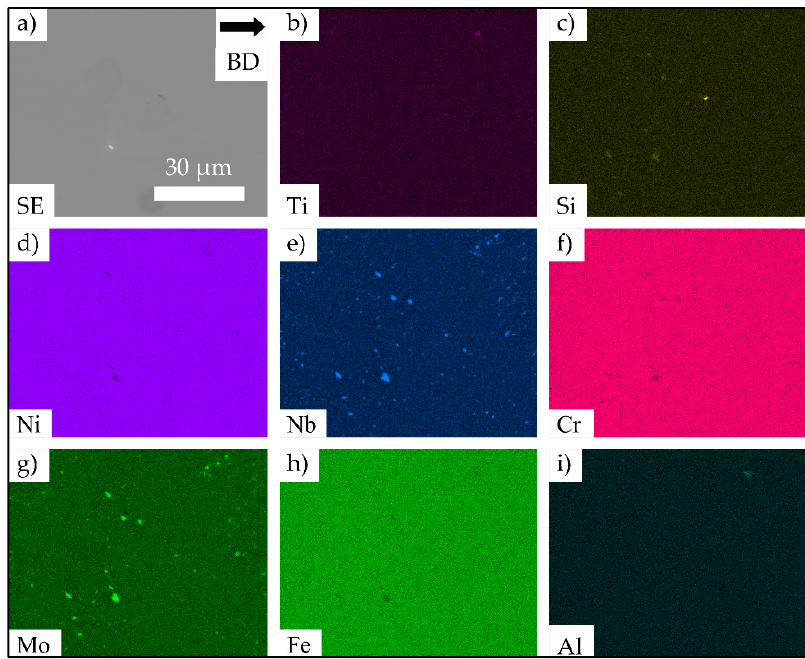
Figure 3. EDS mappings of an area close to the strut surface in direct vicinity of the final crack that was found within the lower half of a strut with a 3 mm diameter after initial testing. ( a ) Reference SE